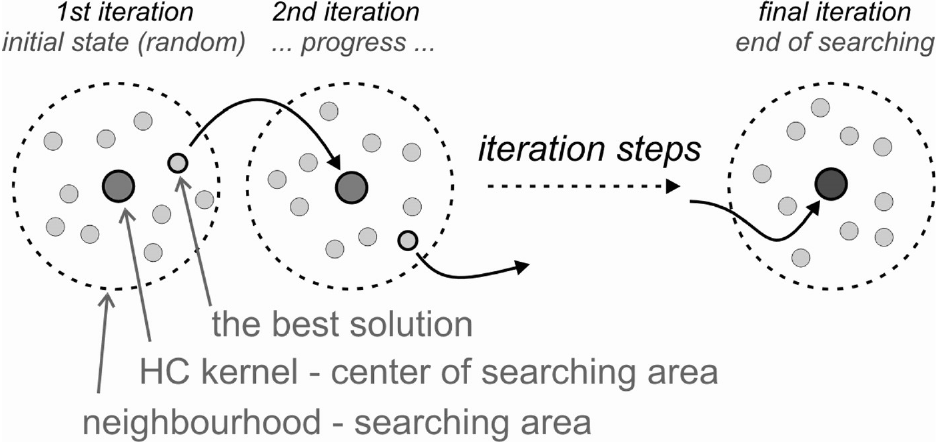
Fig. 1 . An schematic example of the progress of the binary HC